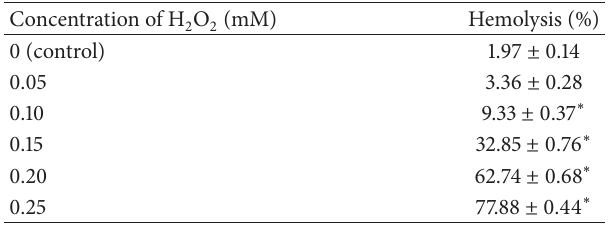
Table 1: H O induced hemolysis. 2 2